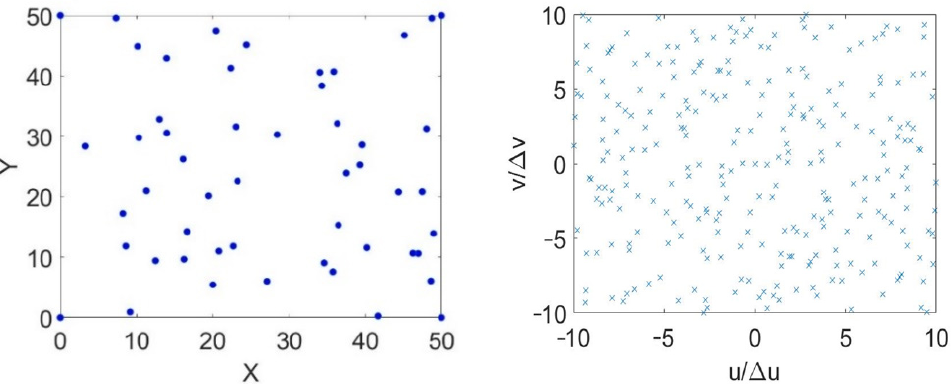
Figure 2. Randomly generated antenna array (after wavelength normalization) and UV plane sampling point.